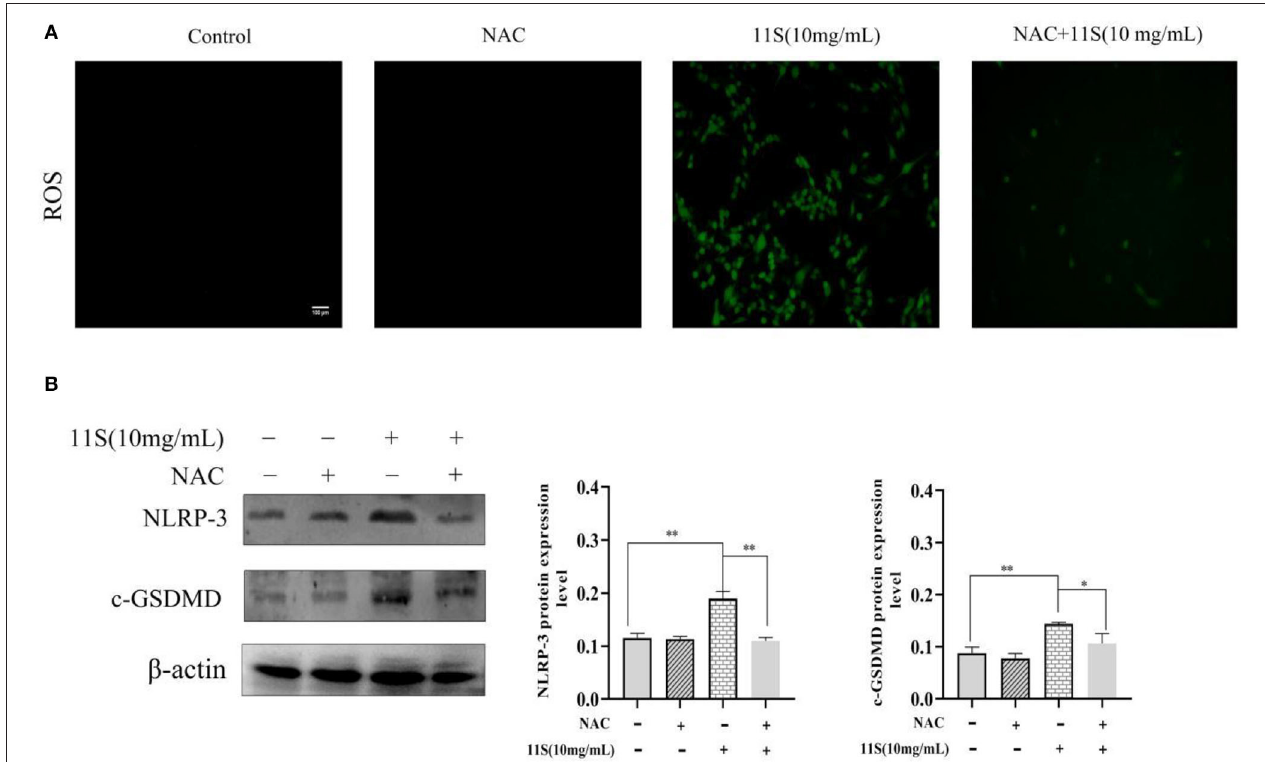
FIGURE 5 | 11S glycinin up-regulates NLRP-3-induced pyroptosis by triggering ROS in IPEC-J2 cells. (A) IPEC-J2 cells were treated with or without NAC (6mM) for 1h before a 24h treatment of 11S glycinin (10 mg · ml − 1 ). (A) ROS were detected using DCFH–DA staining. (B) Western blotting indicates the protein expression of NLRP-3 and c-GSDMD in IPEC-J2 cells. Data are shown as mean ± SD. * P < 0.05, ** P < 0.01, compared with the control